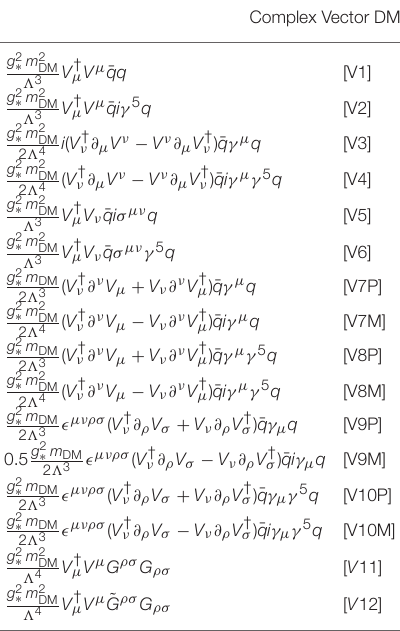
Complex Scalar DM